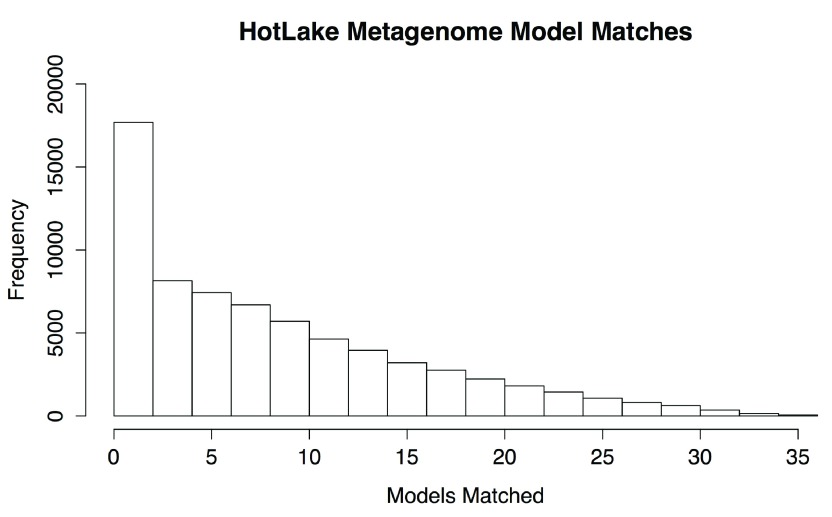
Histogram of MDRpred votes for metagenomic sequences.The number of sequences (Y axis) with N matches (X axis) in the Hot Lake metagenome (69,010 sequences total) is shown as a histogram. This plot can be compared with similar plots in
Supplemental Figure 2 showing accuracy and positive predictive value at each of these stringency thresholds.